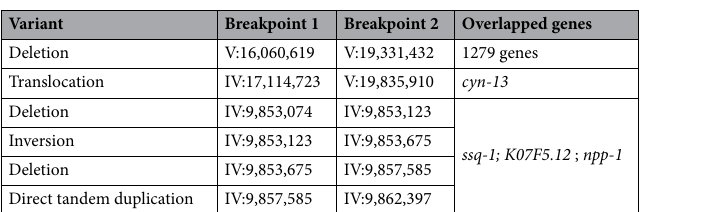
Figure 5. Characterization of the balancer sC4 and a new complex rearrangement in BC4586 on LGIV. ( A ) Coverage analysis of the region surrounding the deletion of the segment V:16,060,619–19,331,432 in BC4586, revealing a large deletion. ( B ) PCR gels validating SVs and complex rearrangements in BC4586. 1 = Direct tandem duplication III:5,059,444–5,063,035; 2 = Deletion IV:9,853,074–9,853,123, inversion IV:9,853,123– 9,853,675 and deletion IV:9,853,675–9,857,585; 3 = Direct tandem duplication IV:9,857,585–9,862,397; 4 = Deletion sC4 V:16,060,619–19,331,432; 5 = Deletion V:20,780,774–20,781,638. The breakpoints validated with the PCR no2 and no3 are part of the same chromosomal rearrangement. ( C ) Representative karyotypes for N2 and BC4586, confirming sC4 chromosome fusion (IV;V) (indicated by a white arrow) in BC4586. The scale bar represents 4 uM. ( D ) Schematic representation of the chromosomal rearrangement on LGIV. The successive SVs are displayed along the genomic region IV:9,851,500–9,863,000. The chromosomal rearrangement is composed of two deletions (blue), one direct tandem duplication (red), and one inversion (green). IGV screenshot of BC4586 aligned reads along the genomic region IV:9,851,500–9,863,000.